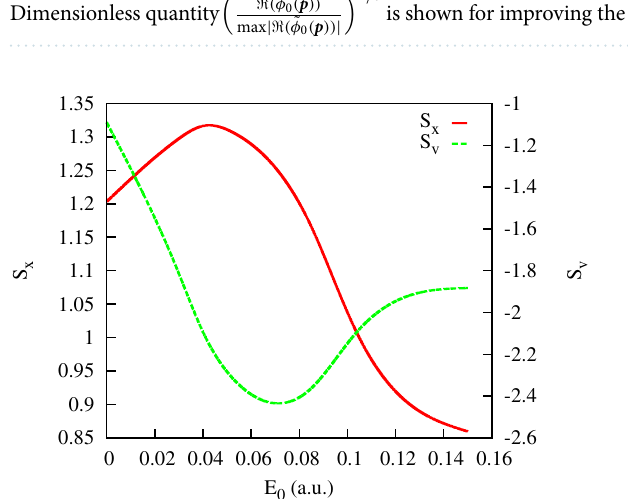
0.0534 a.u. ( c ), E 0 =